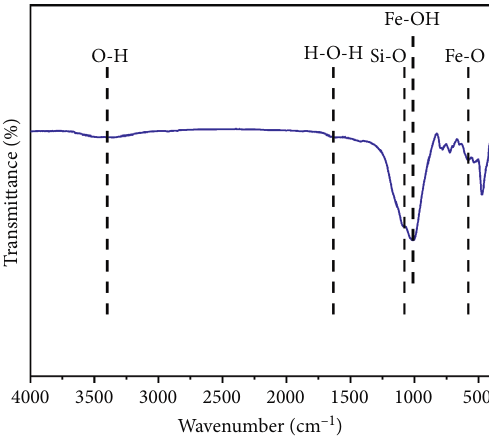
Figure 4: FTIR spectrum of ceramsite adsorbent. Table 3: Langmuir and Freundlich isotherm